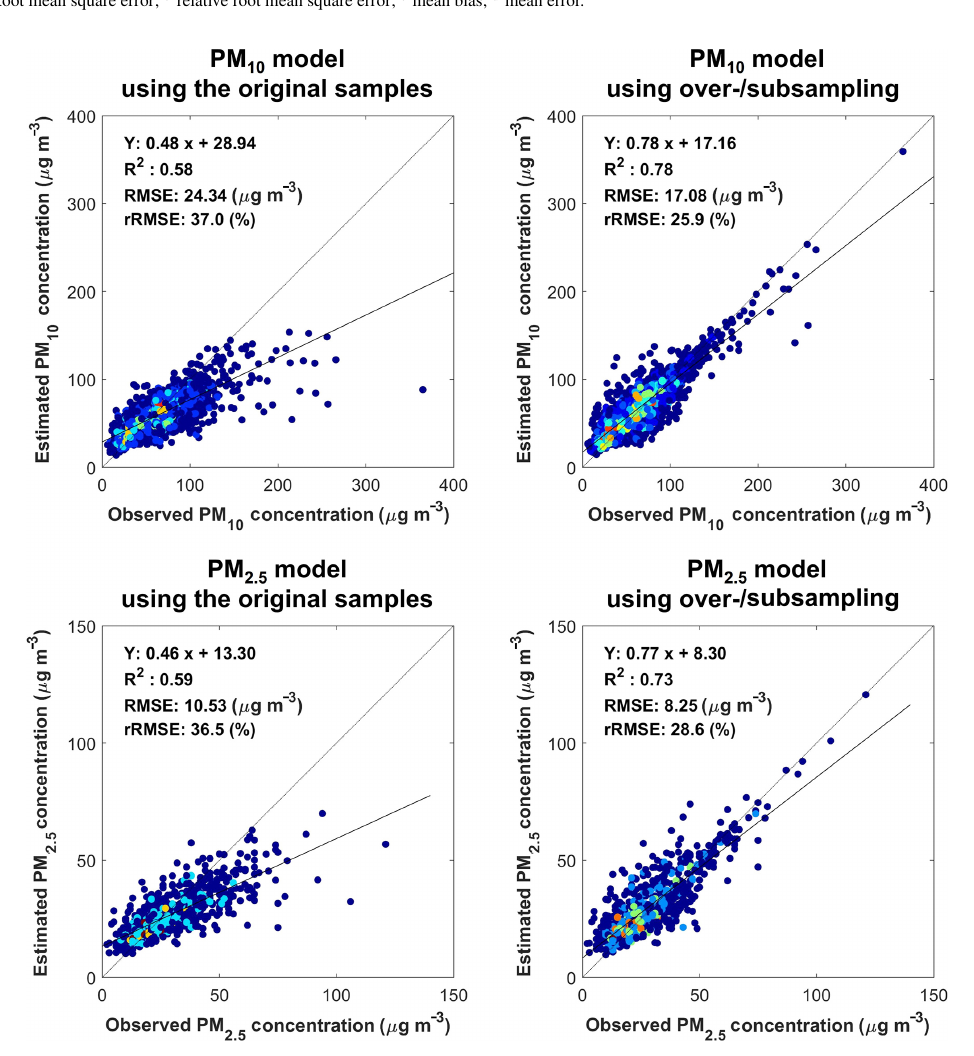
Figure 3. The model test results of daily PM 10 and PM 2 . 5 estimations. The color scheme from blue to red indicates the point density: the blue point means low density, while the red point shows high